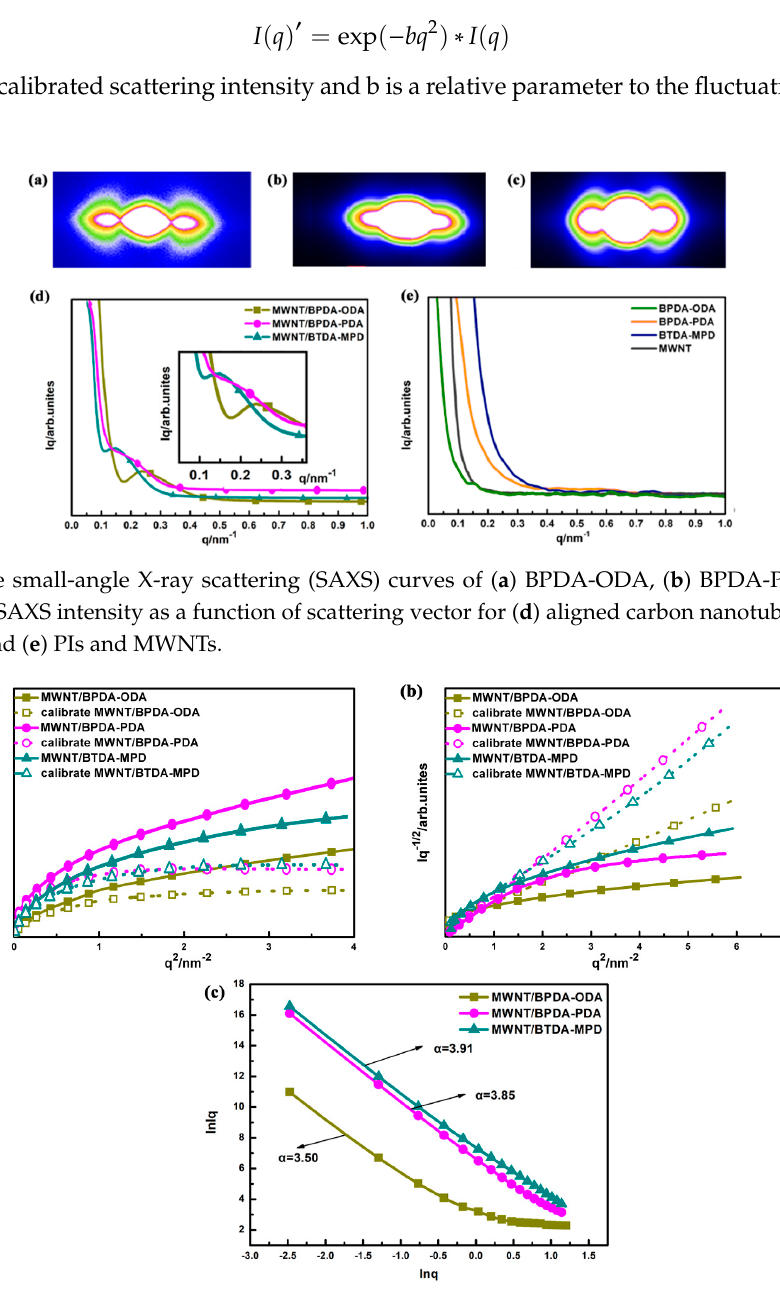
Figure 4. Porod-law analysis ( a ) and Deybe-law analysis ( b ) of scattering curves of the aligned MWNT/PI nanocomposites with actual plots as solid line and calibrated plots as dashed line. ( c ) Double logarithmic curve of the aligned MWNT/PI nanocomposites.